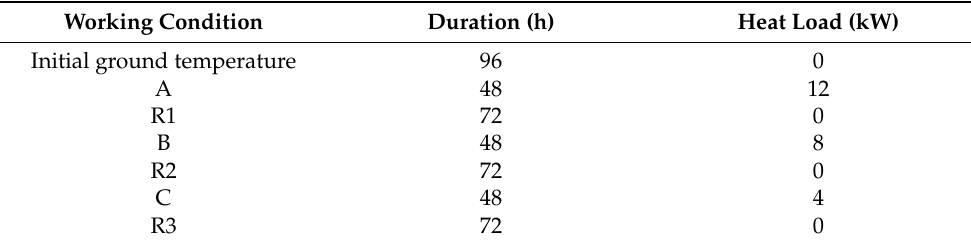
Table 2. Information on the test